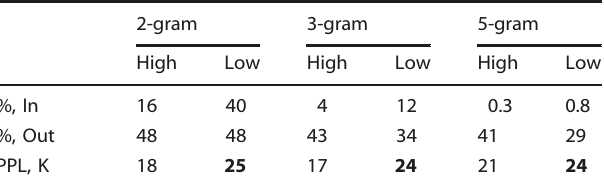
Table 3. Memorisation assessment for 1K samples per n -gram group in the top + meta train-gen-mhr model. high denotes n -grams from the upper frequency quartile; low — n -grams from the lower frequency quartile; %,in denotes percentage of target n -grams in the input key phrases; and %,out — in the respective generated output. Highest PPL values are highlighted in bold.